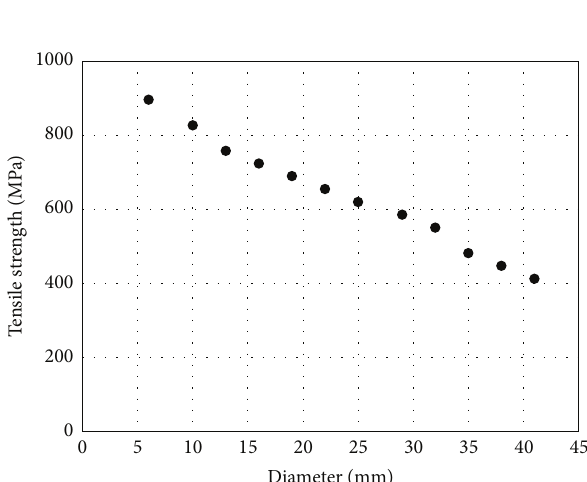
Figure 4: Change of tensile strength with diameter